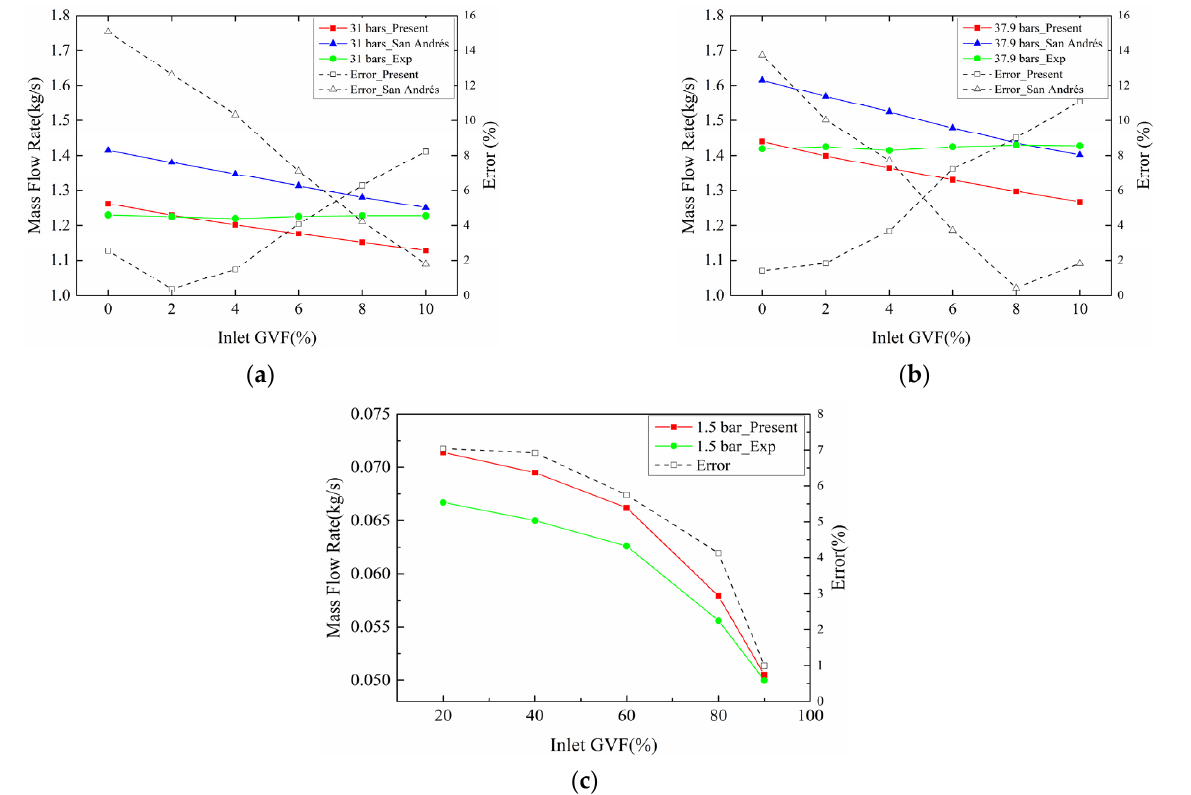
Figure 3. Mass flow rates versus inlet gas volume fraction based on the present model and experiments. ( a ) Δ P = 31 bars, ( b ) Δ P = 37.9 bars, ( c ) Δ P = 1.5 bars.